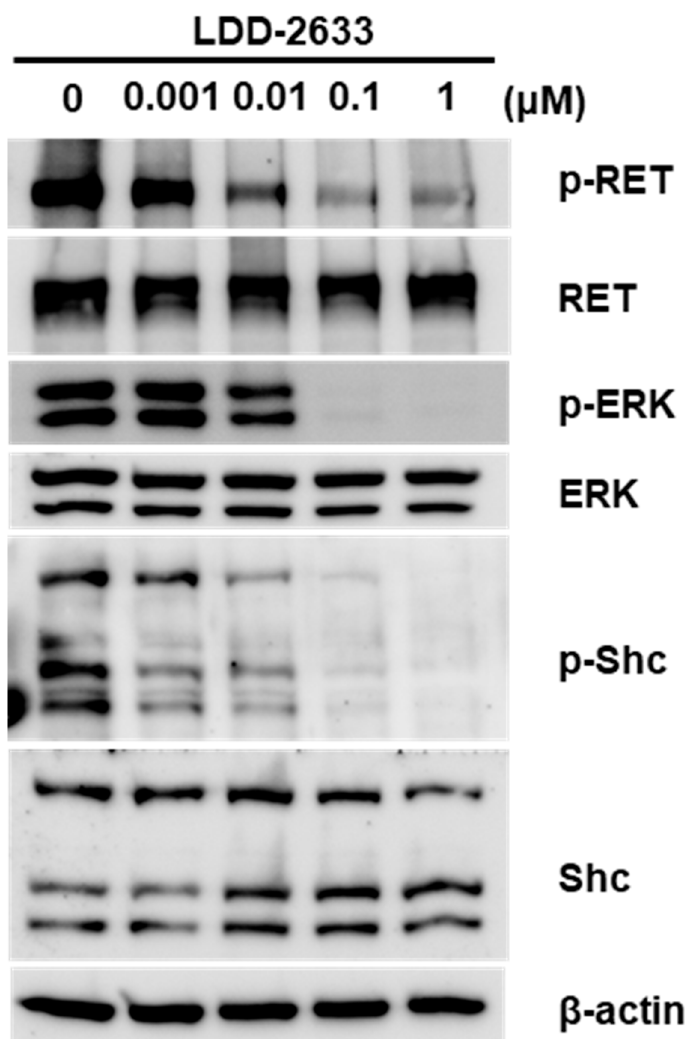
Figure 3. Effect of LDD-2633 on the RET signaling pathway. TT cells were treated with LDD-2633 at the indicated concentration for 48 h. Western blotting experiments were then performed using the indicated antibodies. Blotting images are representative of three independent experiments.